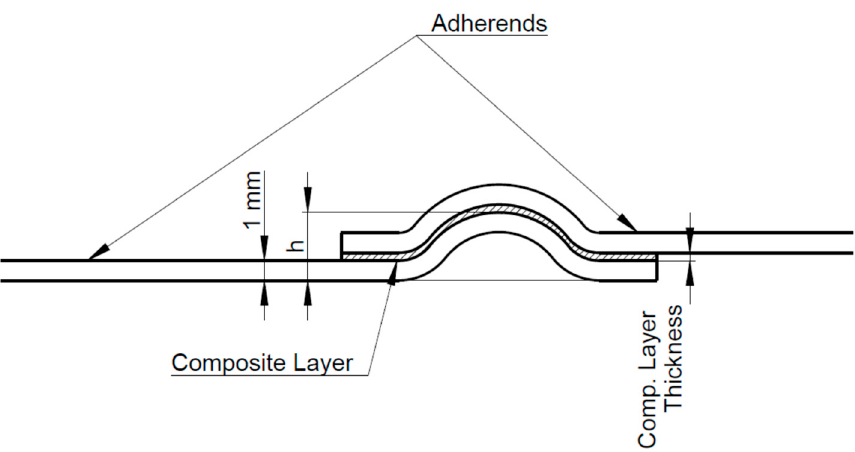
Figure 2. The types of shaped adherends and the measurement principle for height (h) of a wave. The surface of the adherends was mechanically treated in a blasting cabin using abra- sive Garnet MESH 80 and then chemically treated in an acetone bath just before bonding.